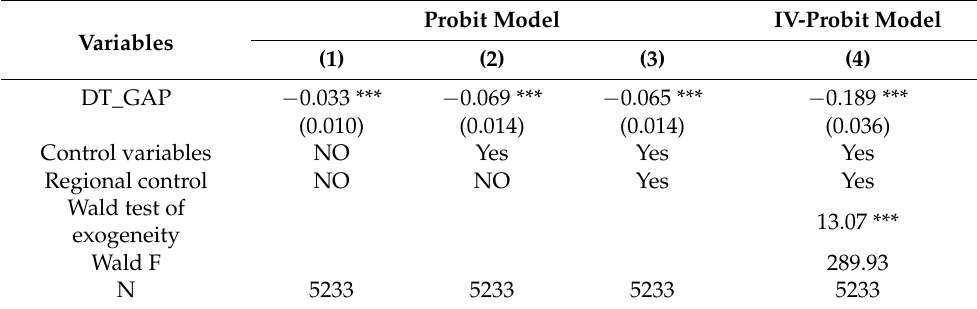
Table 6. Results of the DT_GAP’s impact on